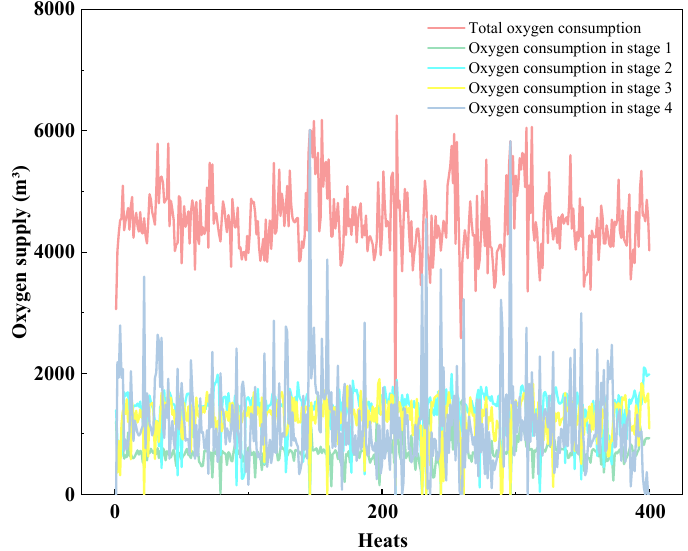
Figure 6. Variation of consumption of oxygen in different stages with heat. Table 4. Characteristic statistics of oxygen supply in different stages of 400